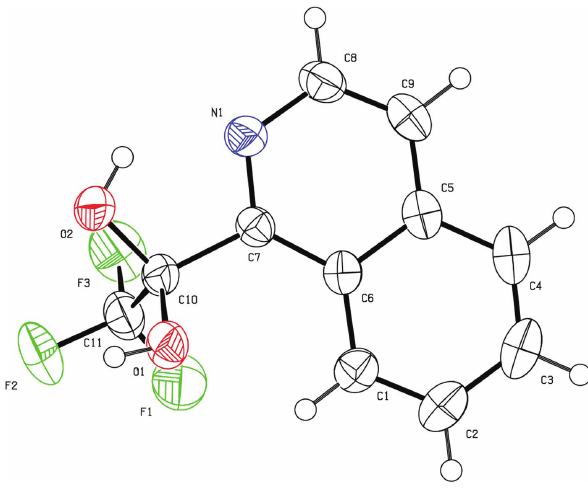
Table 1: Data collection and handling.